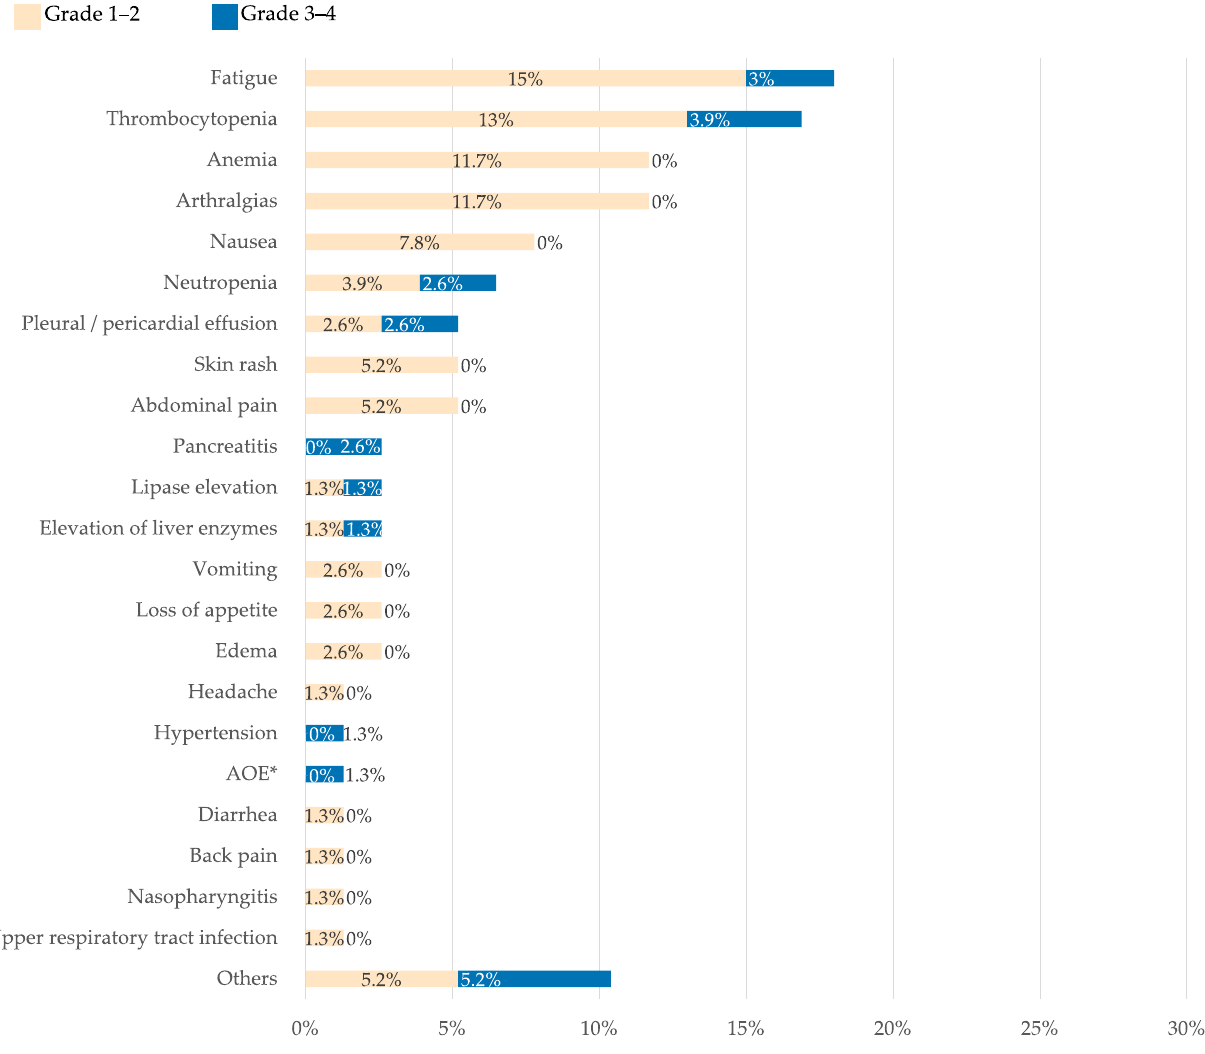
Figure 2. Frequency of adverse effects observed with asciminib. In pale orange: frequency of grade 1–2 adverse effects. In blue color: frequency of grade 3–4 adverse effects. AOE, arterial occlusive event. * Worsening of previous peripheral arterial disease.